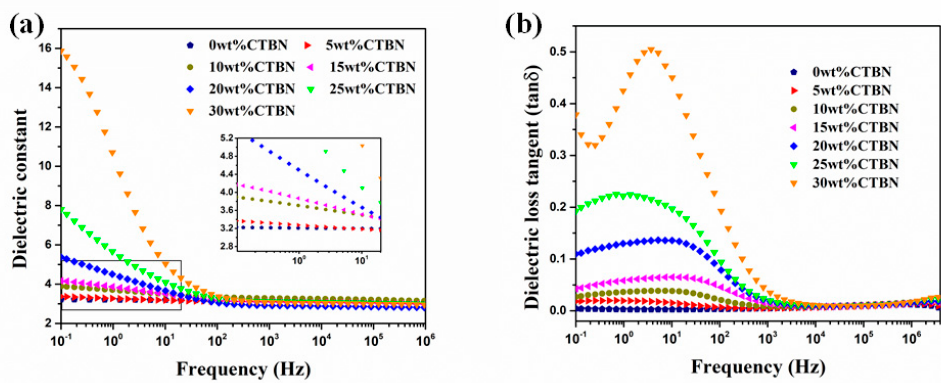
Figure 6. Dependence of ( a ) the dielectric constant and ( b ) the dielectric loss on frequency for composites with different CTBN contents.